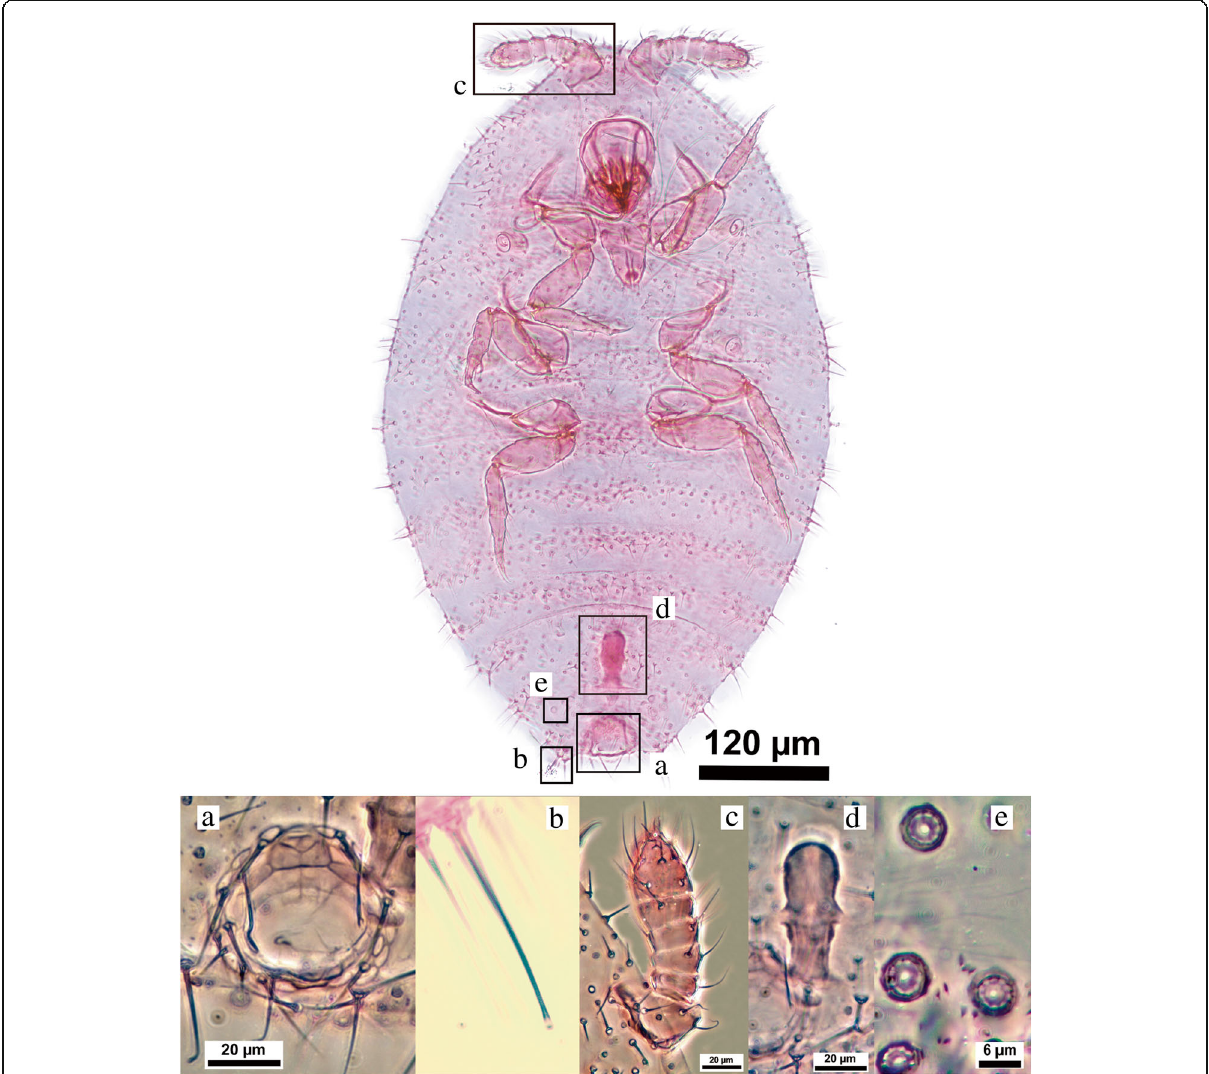
Fig. 2 Photomicrographs of Williamsrhizoecus coffeae Caballero and Ramos sp. nov., with amplified images of the anal ring ( a ), anal lobe clavate setae ( b ), a six-segmented antenna ( c ), the genital chamber ( d ), and multilocular disc pores ( e